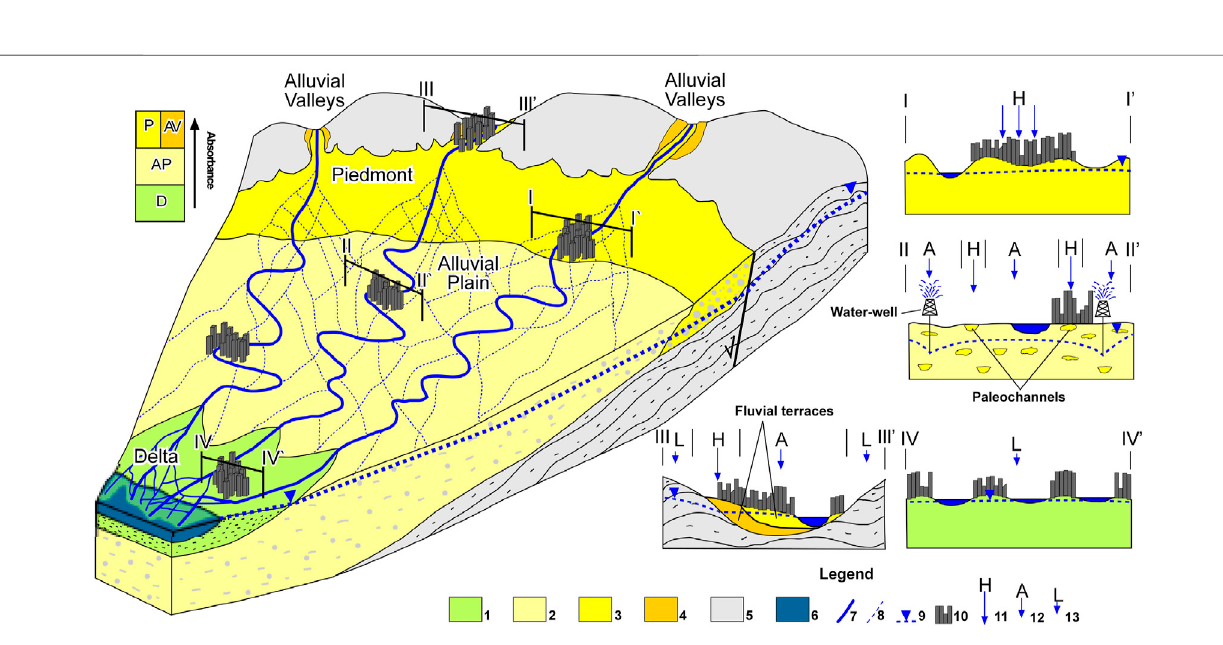
FIGURE 6 | Conceptual zonation for rainfall potential at the catchment scale. Key to the legend: Deltaic sequence (1); Alluvial plain sequence (2); Piedmont and recent terrace sequences (3); older terrace sequence (4); bedrock (5); seawater (6); river (7); paleochannels (8); groundwater table (9); urban areas (10); High (11), Average (12) and Low (13) potential